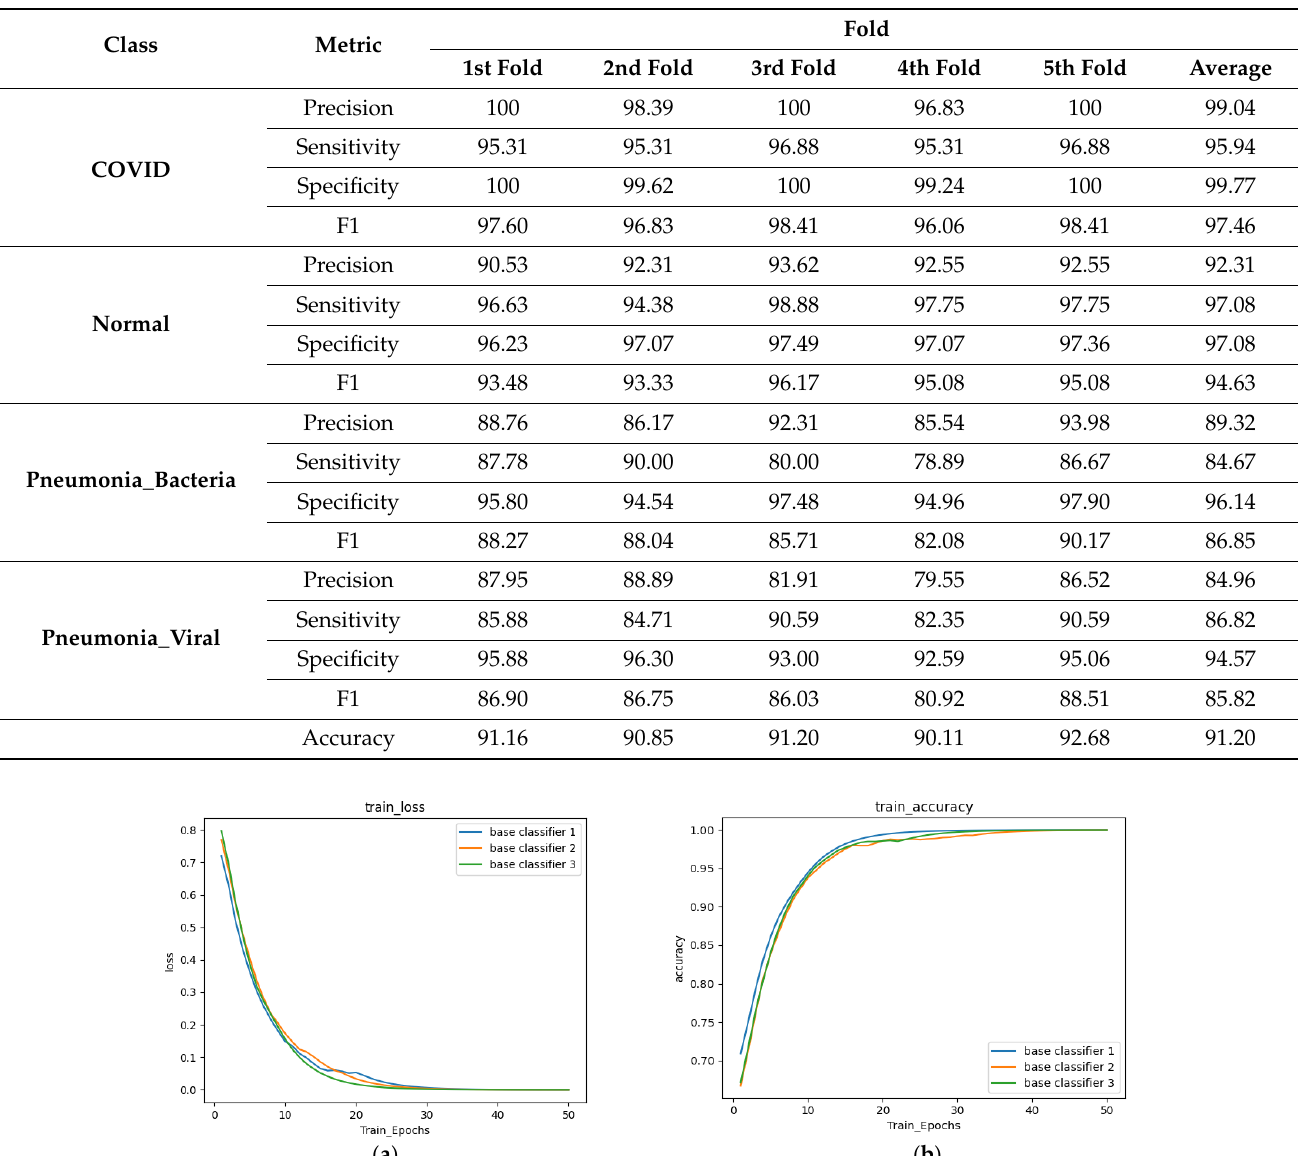
Table 6. The performance of the final proposed architecture, COVIDX-LwNet, at each compromise (D2, 4 class).